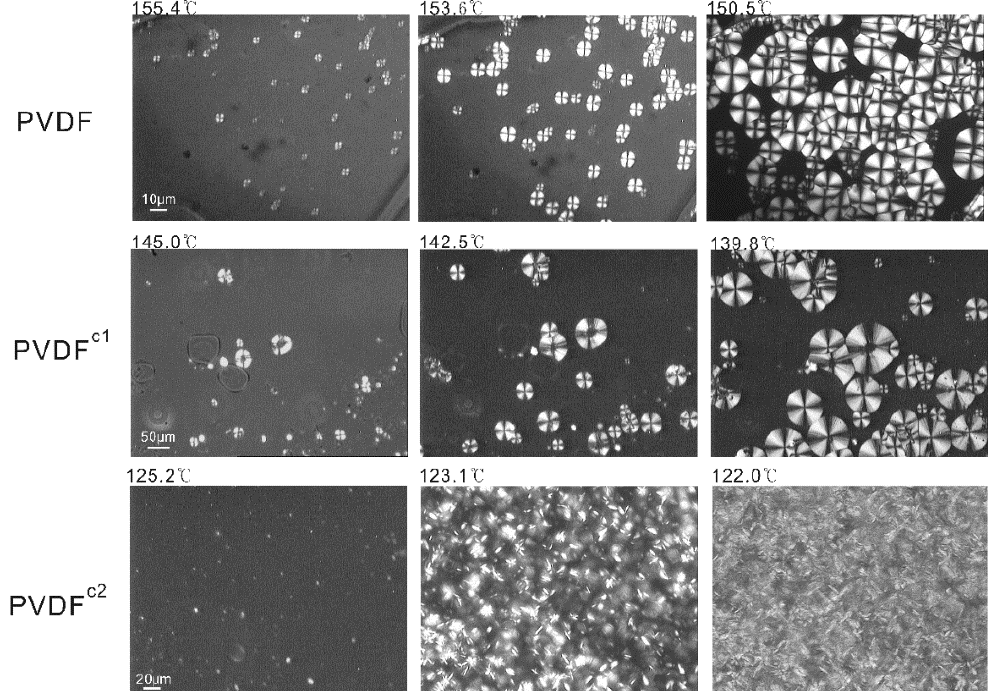
Figure 2. Polarized optical micrograph showing the crystalline morphology of homer- and co-PVDF crystallizing from the melt at a cooling rate of 0.5